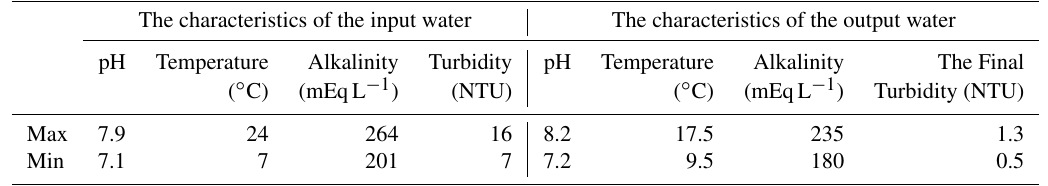
Table 1. Ranges of available data. NTU represents nephelometric turbidity units. The characteristics of the input water The characteristics of the output